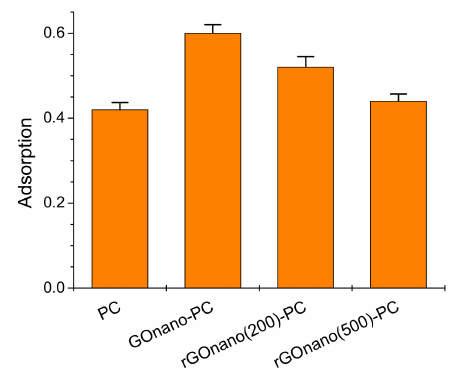
Figure 5. Methylene blue (MB) adsorption on the pristine, GO- and rGO-modified TiO 2 photonic crystals under dark